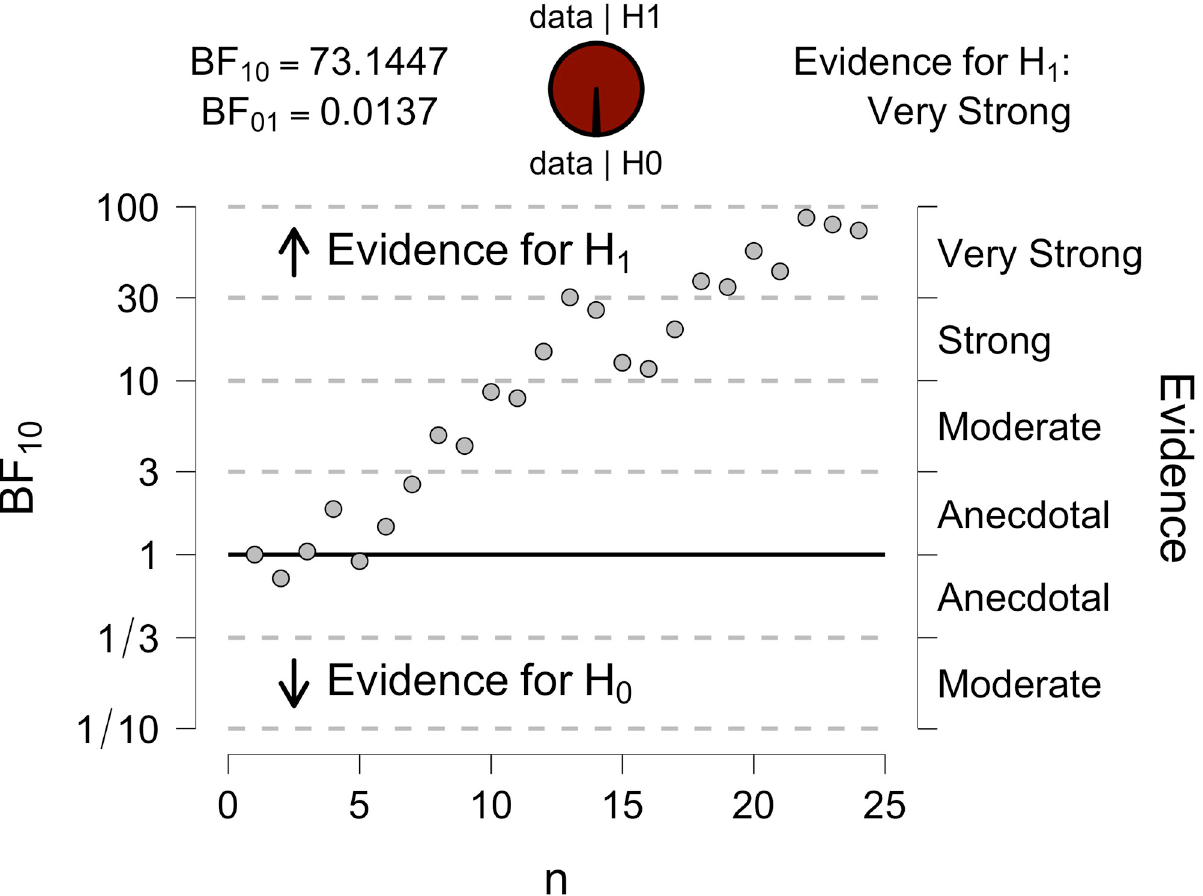
Fig 5. Sequential analysis with Bayesian t -test for the recognition of cello targets under 30 versus 60 ms conditions illustrating the development of evidence as the data accumulates. The data points for each participant are shown on the X-axis, the associated Bayes Factors are shown on the Y-axis.